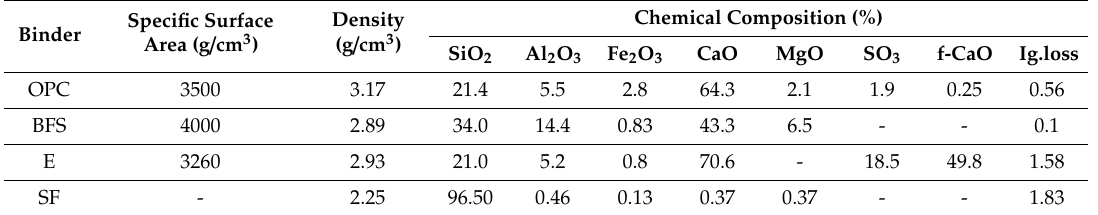
Table 3. Experimental compositions.